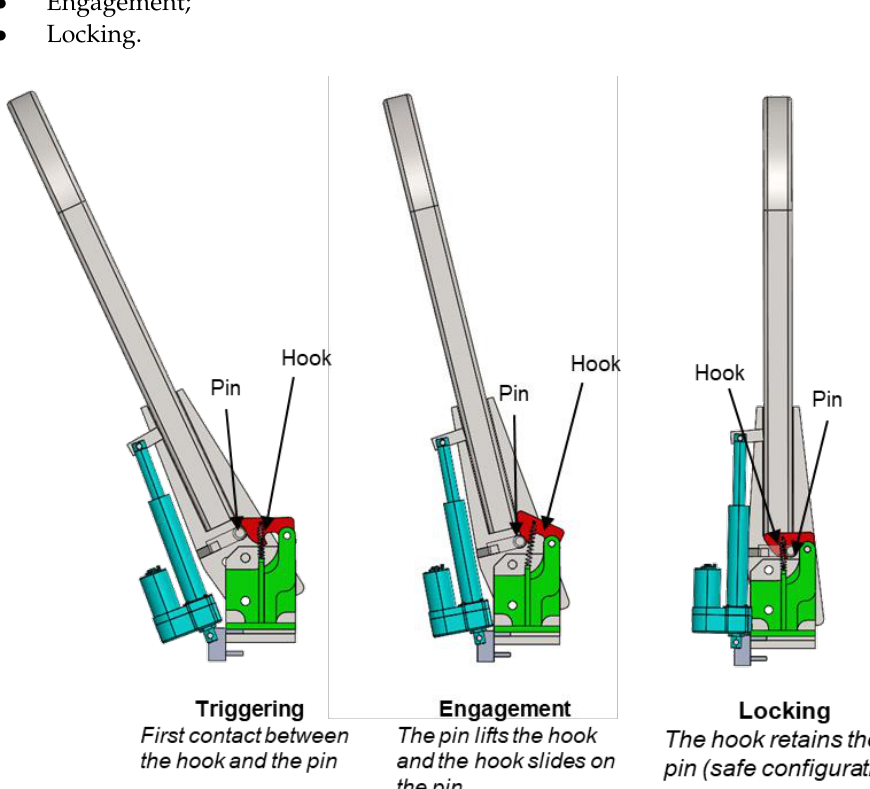
Figure 7. Operating phases of the locking device.